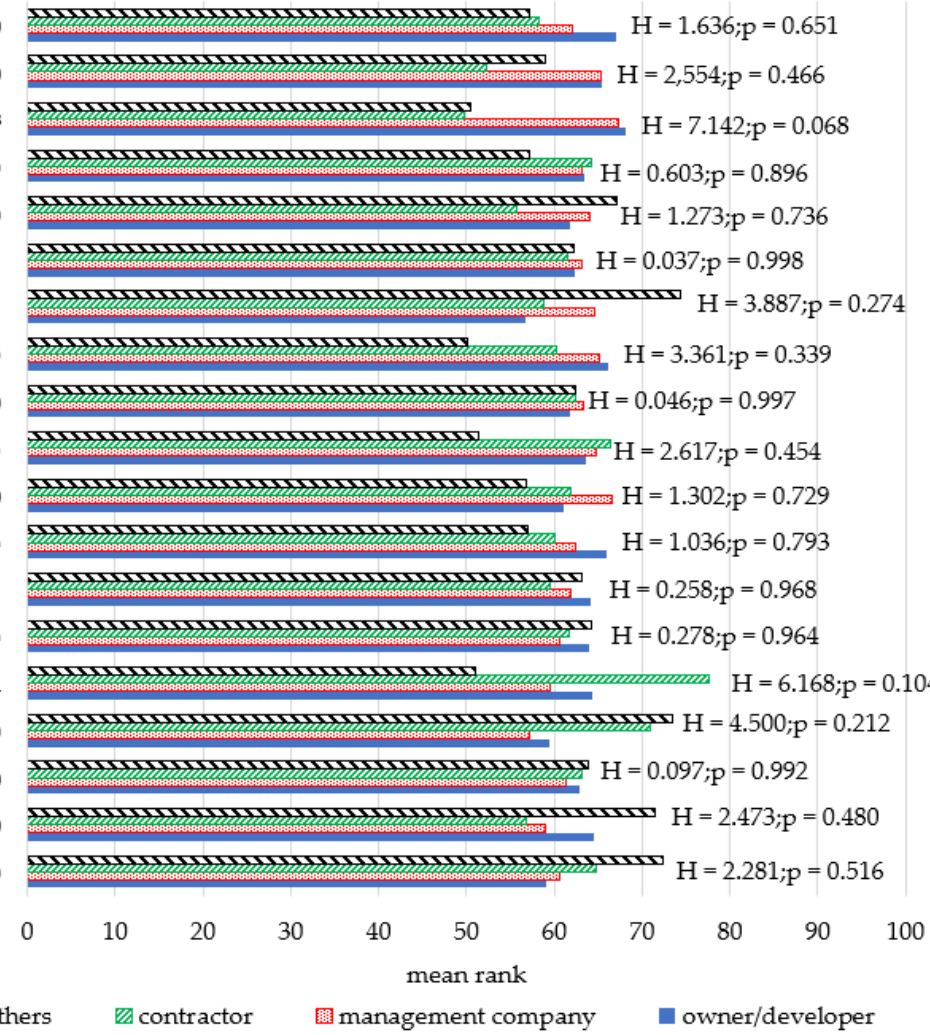
Figure A3. Kruskal – Wallis H-test results of G4 (type of employer). Figure A3. Kruskal–Wallis H-test results of G4 (type of